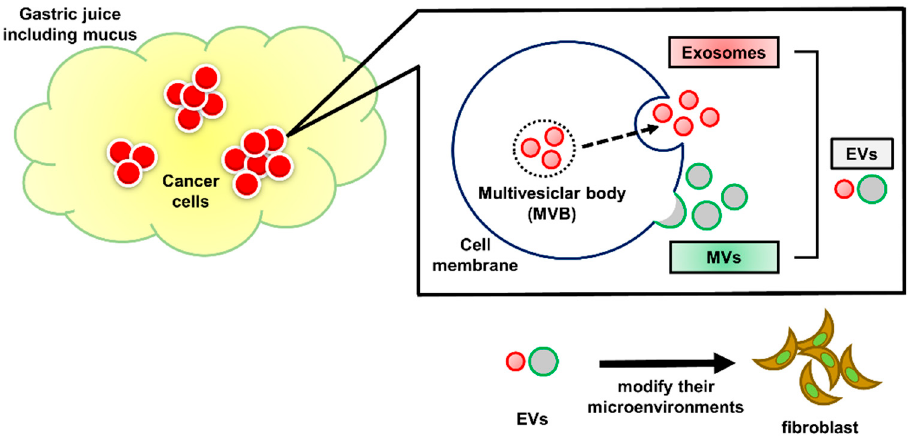
Figure 7. Schematic diagram of our study. GJ of GC patient contains EVs. GC cells partially construct their microenvironment such as fibroblasts through genes of GJ-EVs.